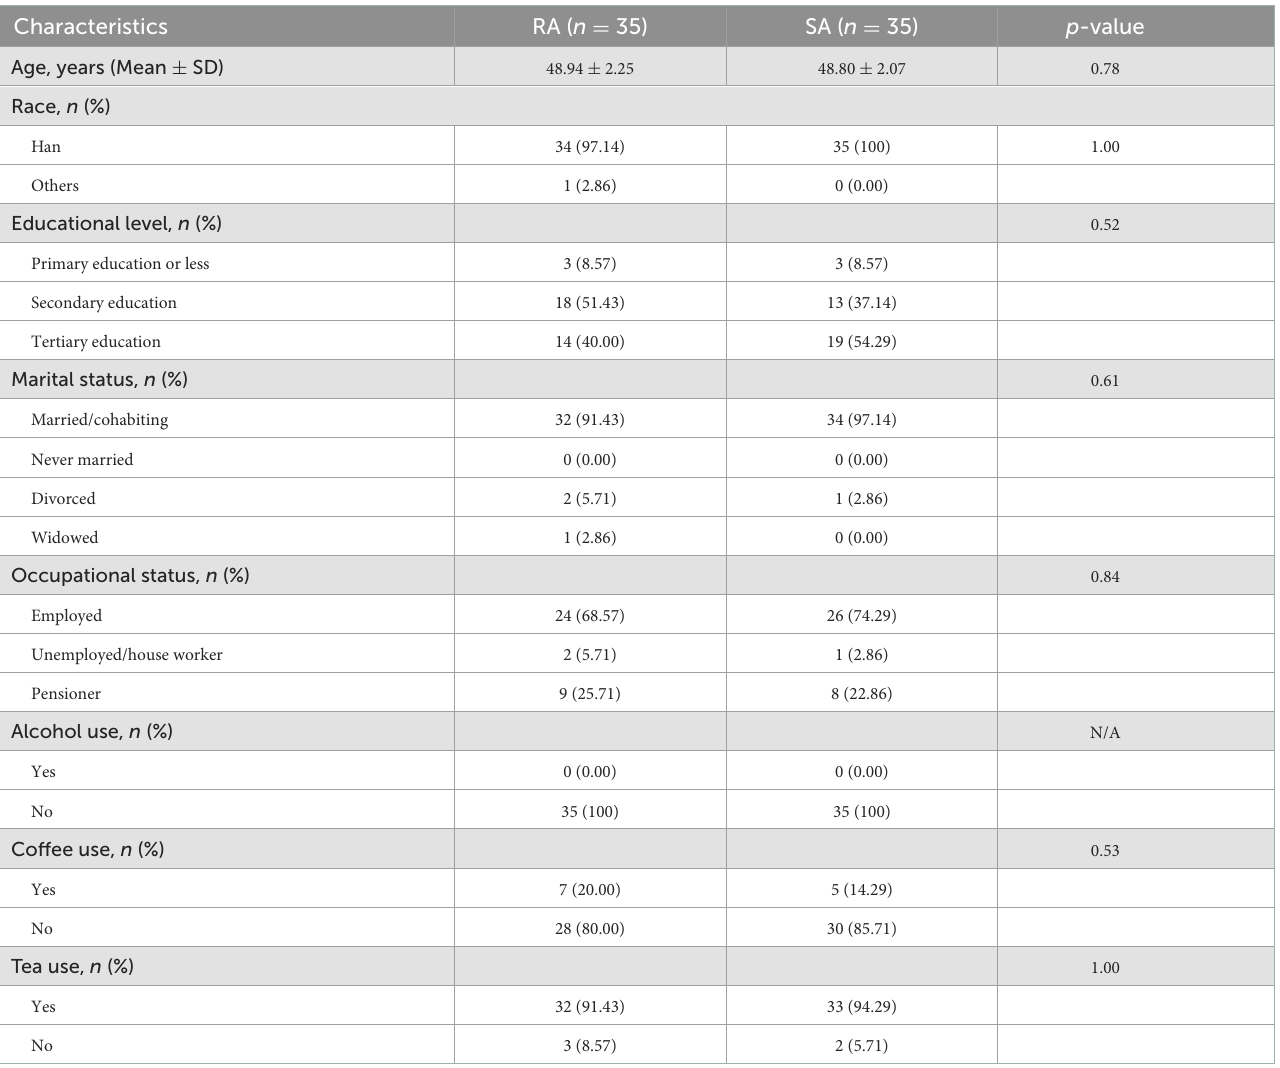
TABLE 1 Socio-demographic characteristics of participants (participants =